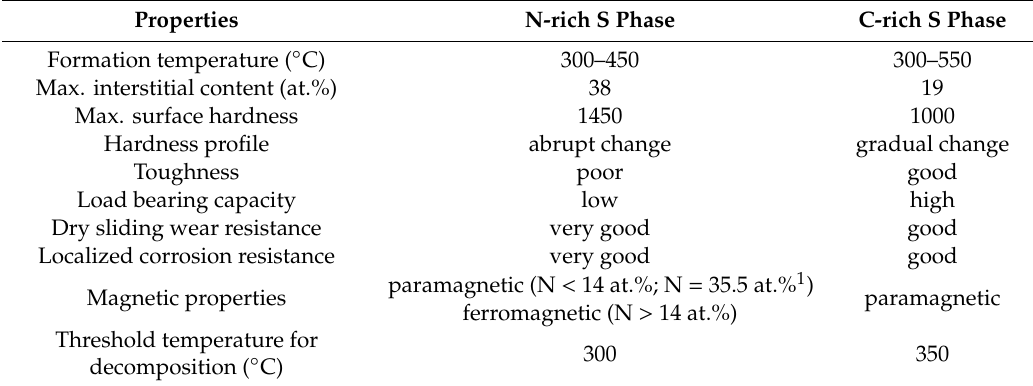
Table 1. Main characteristics on N-rich and C-rich S